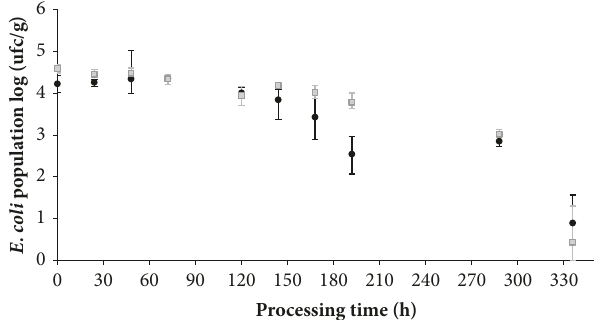
Figure 3: Dynamics of E. coli population during the processing of salami: fermentation at 21 ∘ C from 0 to 48 h and ripening at 17 ∘ C to 336 h (14 days). Treatments: Ls-Sc (grey square) and Ls-Sc + (black circle). The bars indicate the confidence